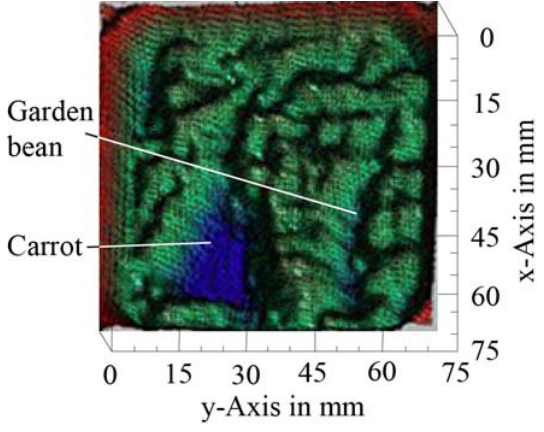
Figure 11. The transmission image of the dish sample holder filled with Soil 1, a piece of carrot and a garden bean [see Figure 4(a)]. The image is in arbitrary units in rainbow colors from red, high intensity, to blue, low